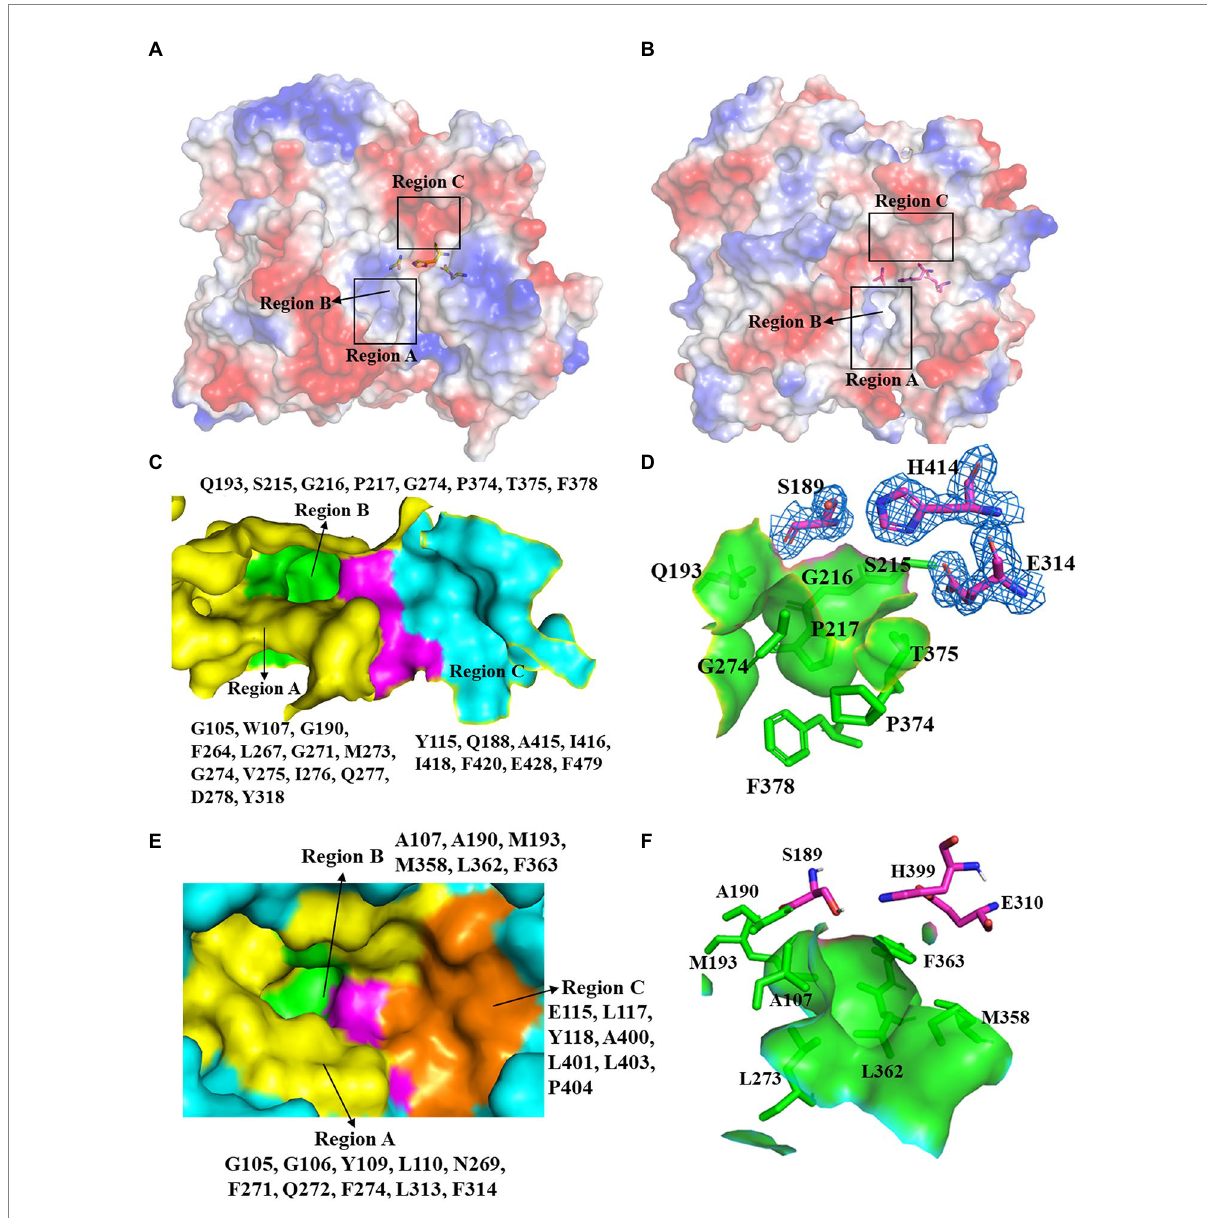
FIGURE 4 Comparison of the catalytic pockets of E93 and pnbCE. (A,B) The electrostatic surfaces of E93 (A) and pnbCE (B) . Sticks show catalytic triad. The positive charged regions are shown in blue and the negative charged regions are shown in red. Regions A–C are specifically noted. (C) The detailed exhibition of catalytic pocket of E93 and the amino acid composition of each region. The magenta area indicates the catalytic triad. (D) Specific features of the Region B in E93. The amino acids that constitute Region B are shown as green sticks. The catalytic triad of E93 is precisely immerged in an electronic density map contoured to 1.0 σ at the 2Fo-Fc map closing to the Region B. (E) The detailed exhibition of catalytic pocket of pnbCE and the amino acid composition of each region. The magenta area indicates the catalytic triad. Amino acids that comprise different regions are shown. (F) Specific features of the Region B in pnbCE. The catalytic triad is shown with magenta stick. The amino acids that constitute Region B are shown with green